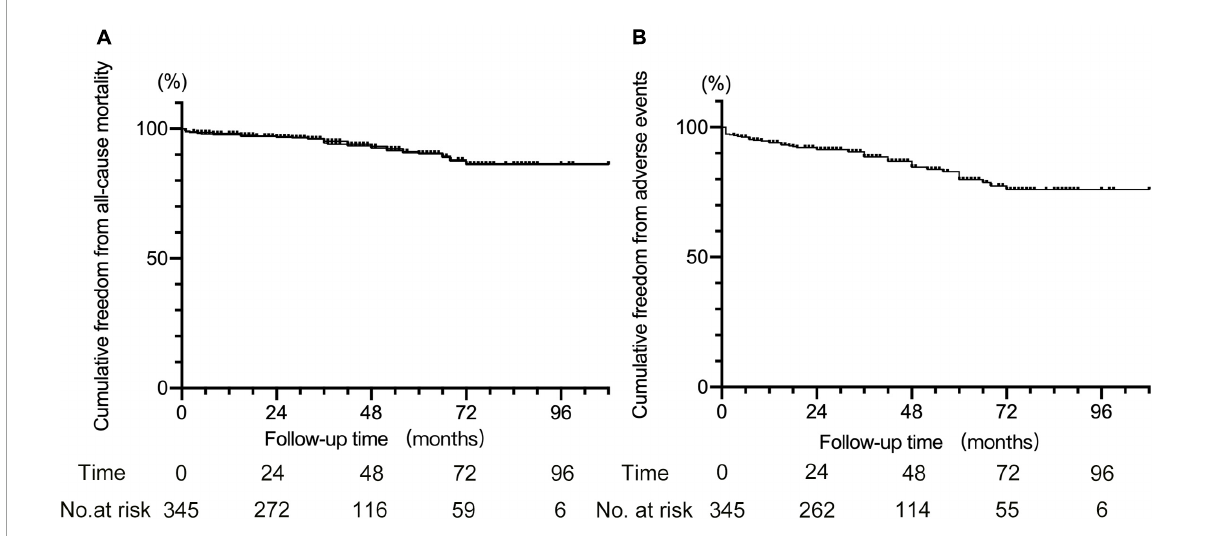
FIGURE3 Kaplan–Meier curve for cumulative freedom from all-cause death (A) and from adverse events (B) after cTEVAR.